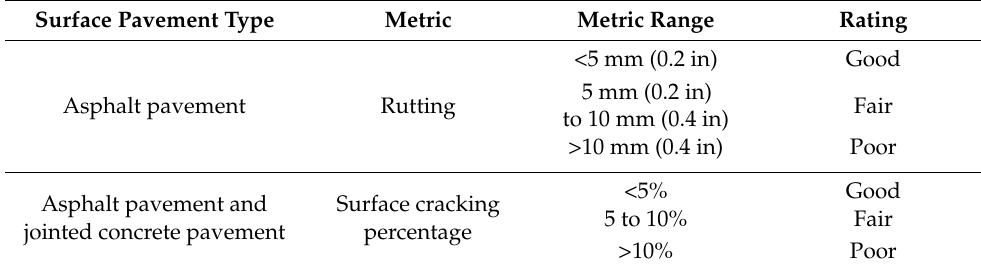
Table 3. Proposed pavement condition rating thresholds from